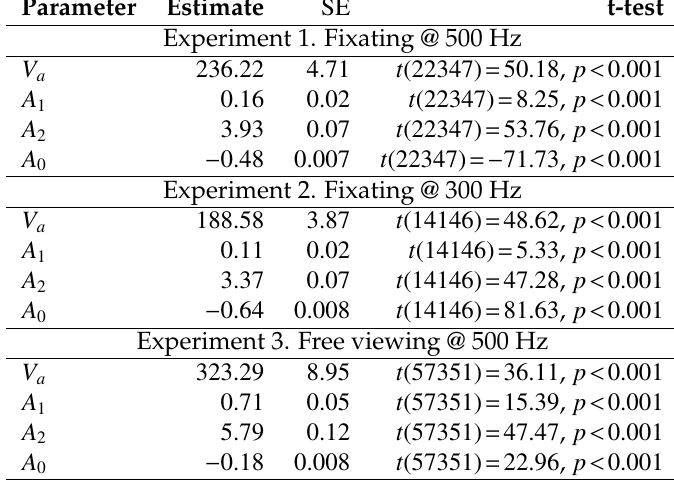
Non-linear regression coefficients and their significance tests for the inverse-linear logistic function fit to microsaccades . Parameter